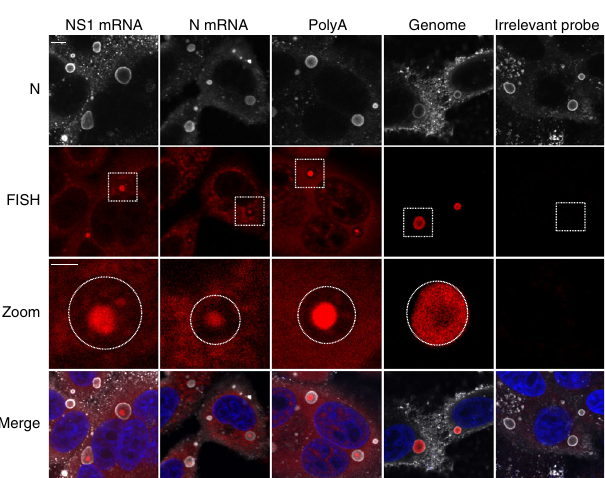
Fig. 2 Localization of viral RNAs in RSV-infected cells. HEp-2 cells were infected with RSV for 24 h. FISH analyses were performed with speci fi c probes ( red ) (as described in Methods) to detect polyadenylated RNA (PolyA), NS1 mRNA, N mRNA or viral genomic RNA as indicated on the pictures. A negative control was performed by probing G mRNA of VSV (irrelevant probe). Cells were also stained with an anti-N antibody ( gray ) and Hoechst 33258 (merge). Representative images from three independent experiments are shown. Images were taken under a confocal microscope. Scale bar 5 µ m. The boxed areas enclose IBs that are shown magni fi ed (zoom), scale bar 2 µ m. Circles represent the borders of “ IB-associated granules ” or IBAGs. A faint FISH signal was also detected throughout the cytoplasm, suggesting the cytosolic presence of N and NS1 mRNAs. By contrast, the viral genomic RNA was detected exclusively in IBs. However, unlike viral mRNAs, the genomic RNA signal was present throughout the whole IBs except the IBAGs. The speci fi city of FISH signal was